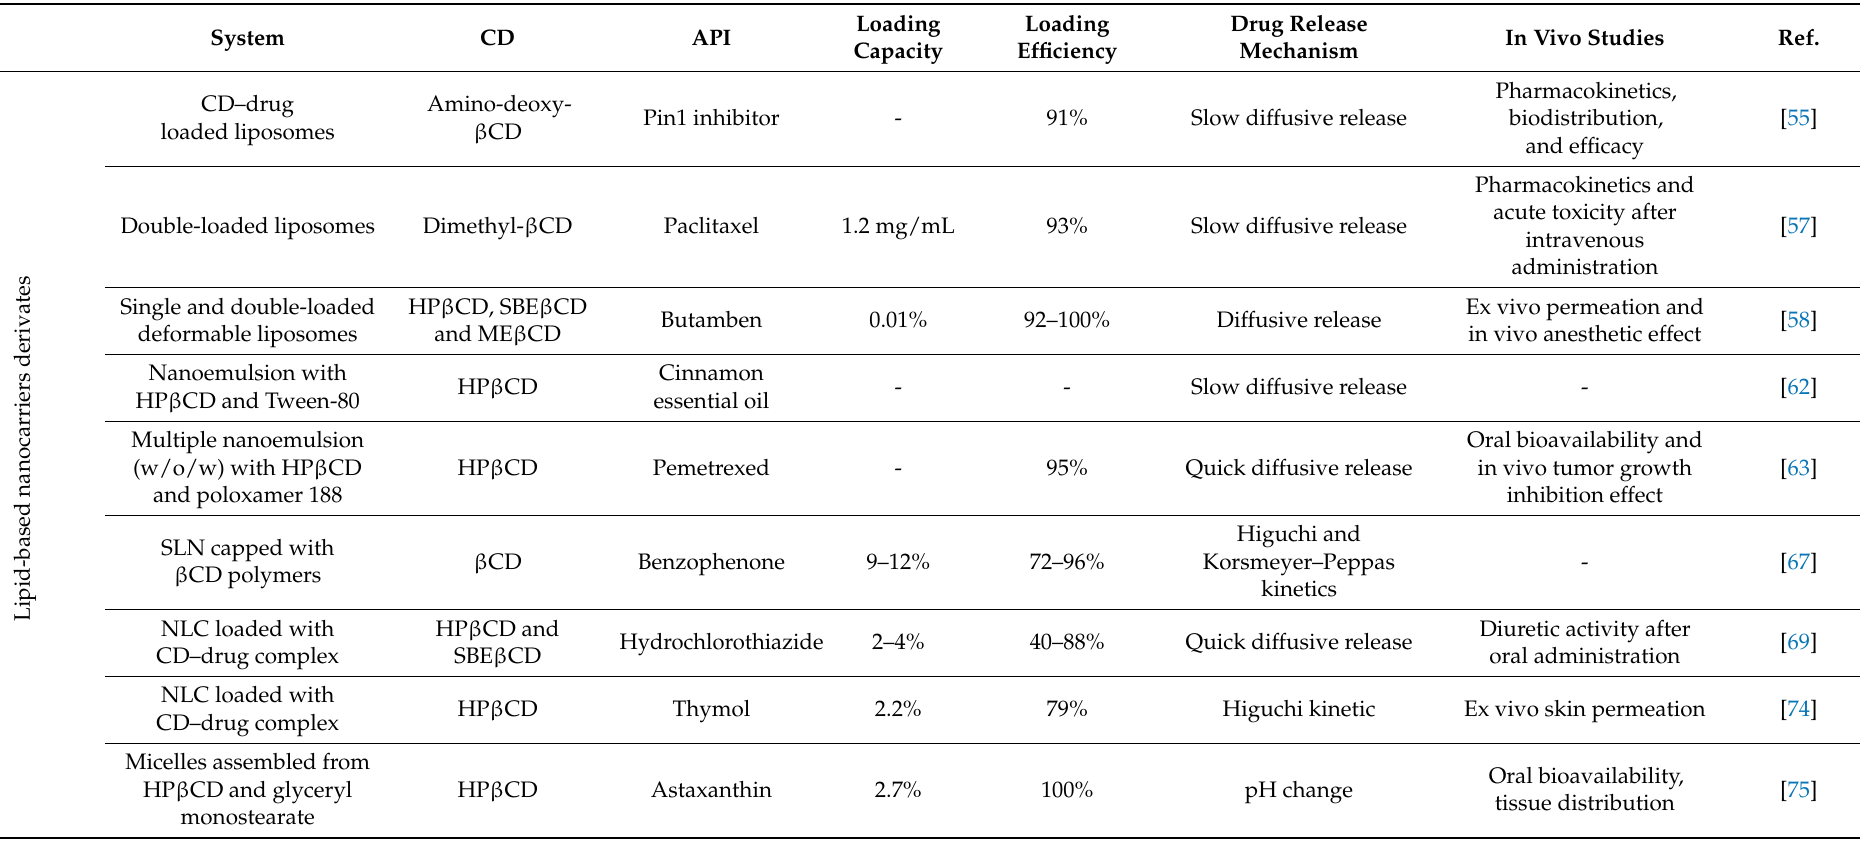
Table 1. Summary of the most important data based on the classification according to the type of nanosystem, type of CD used, types of polymers, and results regarding drug loading, release mechanism, and in vivo studies (if available) from Sections 2.1 and